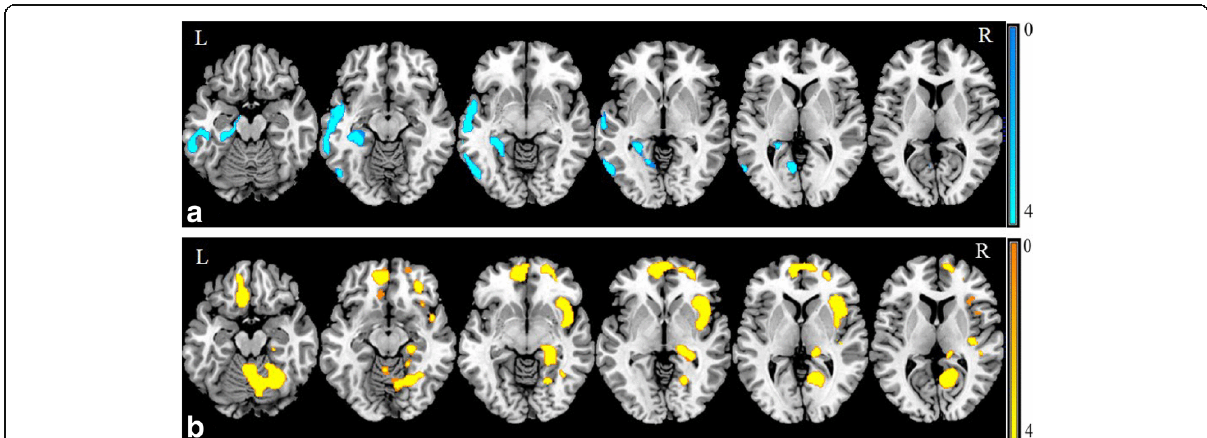
Fig. 1 SPMt map of significant changes in brain metabolism after epilepsy surgery. a Regions with significant decreased metabolism (blue) were mainly in the left temporal and occipital lobes. b Regions with significant increased metabolism (yellow) were mainly in the bi-frontal, right temporal, occipital, and parietal lobes; right thalamus; cerebellum; and vermis. SPMt maps were thresholded at uncorrected p <0.001 at the voxel level combined with a FWE-corrected p <0.05 at the cluster